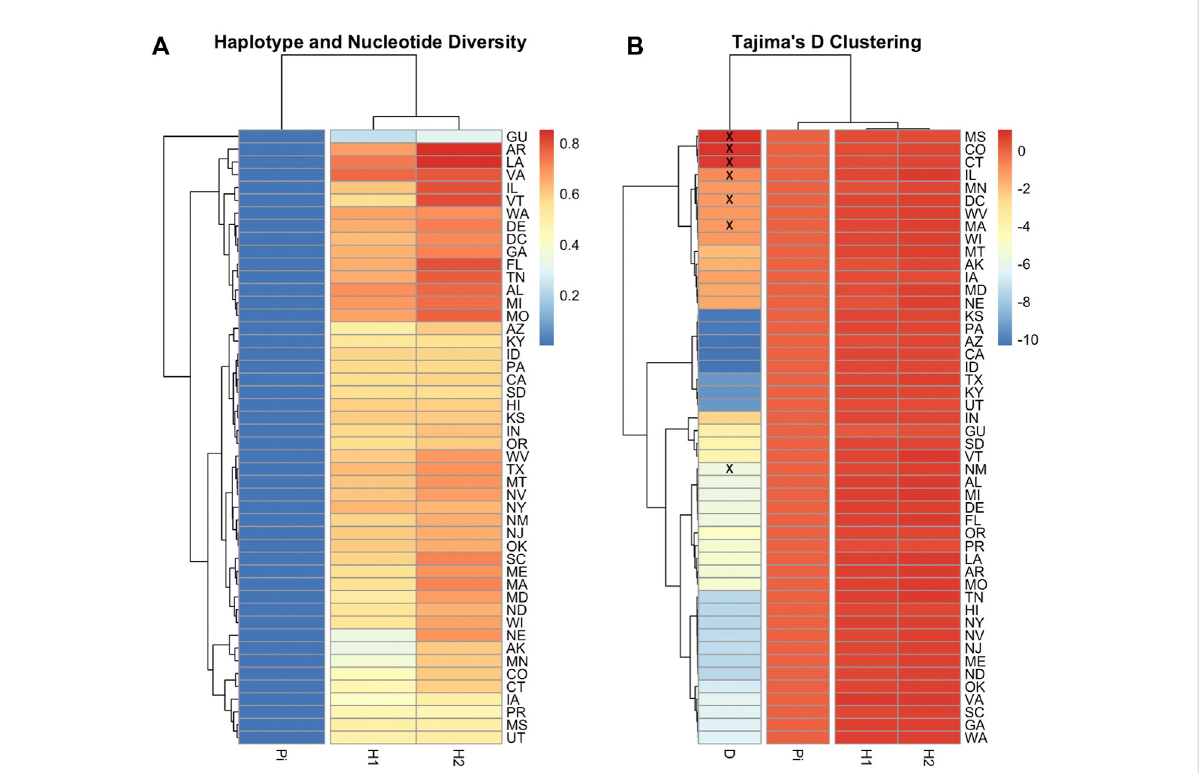
FIGURE 9 Heatmaps illustrating COI-COII gene diversity per population. Nucleotide diversity (Pi), Haplotype diversity calculated based on endonuclease fragment variations ( H 1 ) ( NEIANDTAJIMA 1981), Haplotype diversity computed on DNA sequences ( H 2 ), Tajima ’ s statistic ( D ). (A) : Genetic relationship among populations based on gene diversity parameters ( H 1 , H 2 , Pi). (B) : Population clusters based on Tajima ’ s D values. Population with non- signi fi cant D values ( p > 0.05) were crossed by (x). Full range of data is available in Supplementary Table